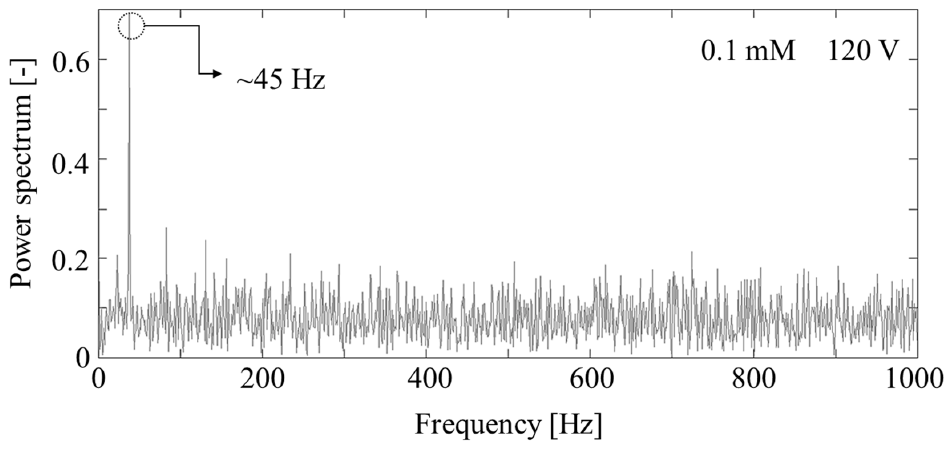
Figure 3. Example of the power spectrum.